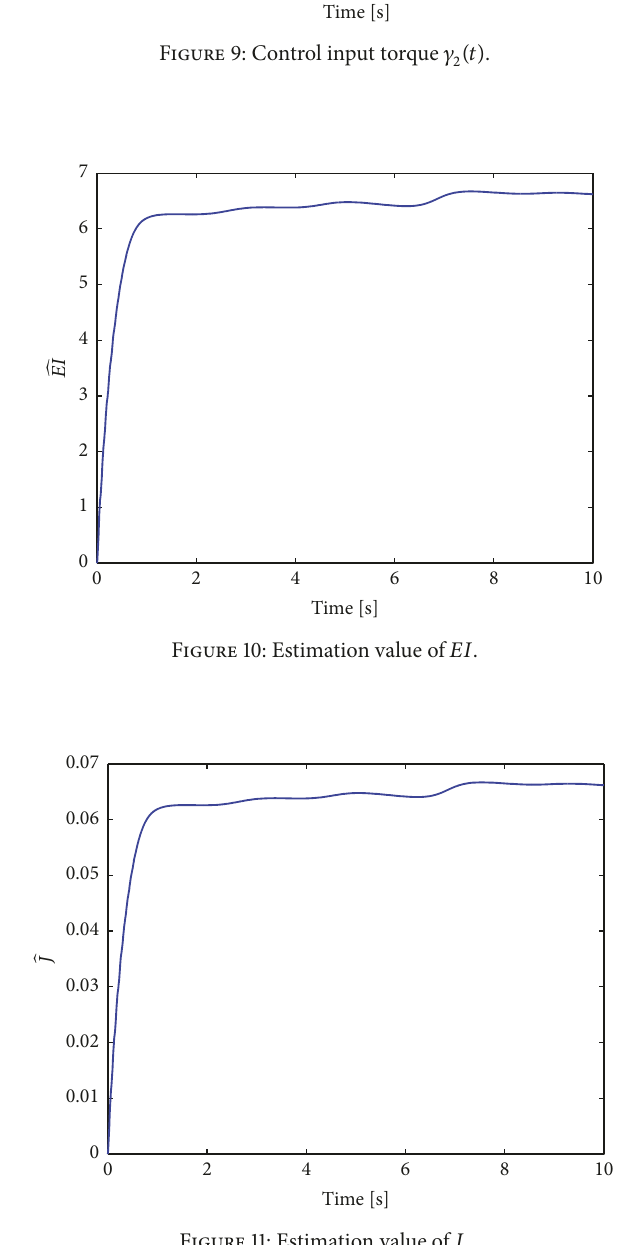
Figure 11: Estimation value of 𝐽 .